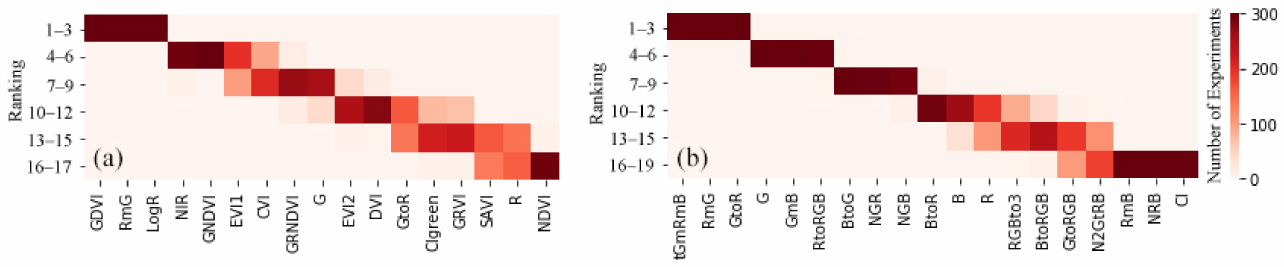
Figure 10. Statistics of VI rankings in 300 experiments using 0.045 m GSD data from ( a ) multispectral sensor and ( b ) RGB